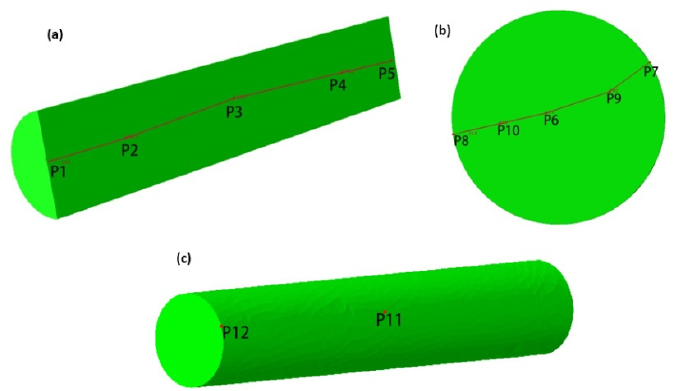
Figure 5. The distribution of characteristic points: ( a ) P1–P5; ( b ) P6–P10; ( c ) P11 and P12.